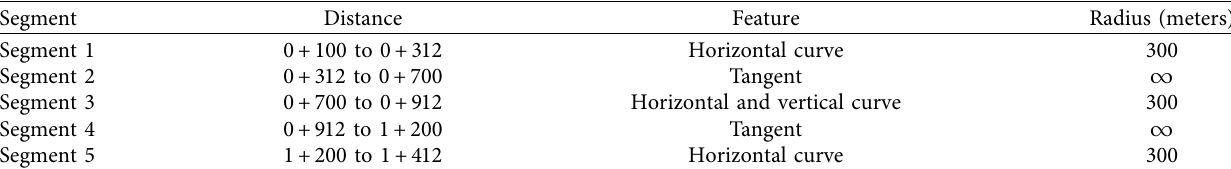
Table 2: Road segments’ description including the location and the geometric features.